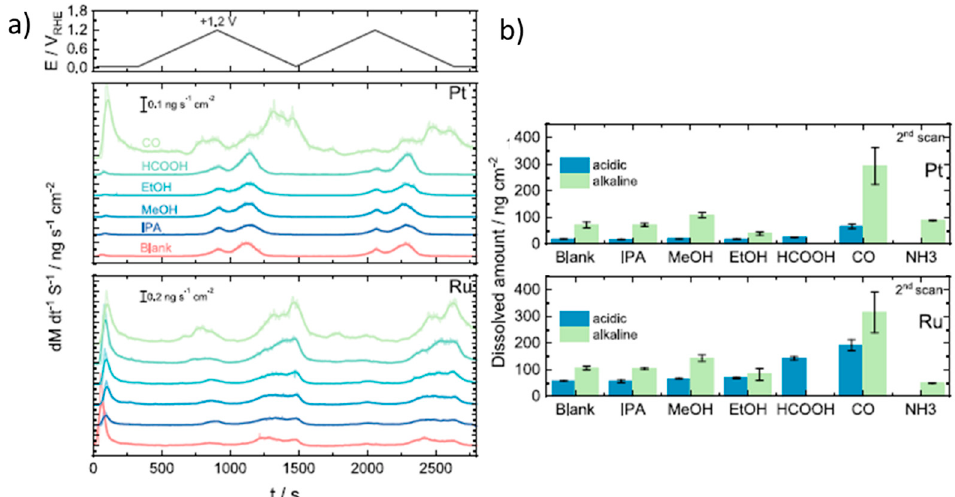
Figure 3. ( a ) Potential sweep profile along with dissolution rates of Pt (top) and Ru (bottom) for the PtRu 1:1 catalyst recorded during cyclic voltammetry from +0.05 to +1.2 V vs. RHE, at 2 mV s − 1 , in 0.1 M HClO 4 and in the presence of various fuels, i.e., 0.1 M HClO 4 + 0.05 M fuel (in the case of CO, the electrolyte is saturated). ( b ) Absolute dissolved amounts of Pt (top) and Ru (bottom) in the presence of each fuel both in 0.1 M HClO 4 and 0.05 M KOH solutions. Reprinted with permission from Ref. [77] Further permissions related to the material excerpted should be directed to the